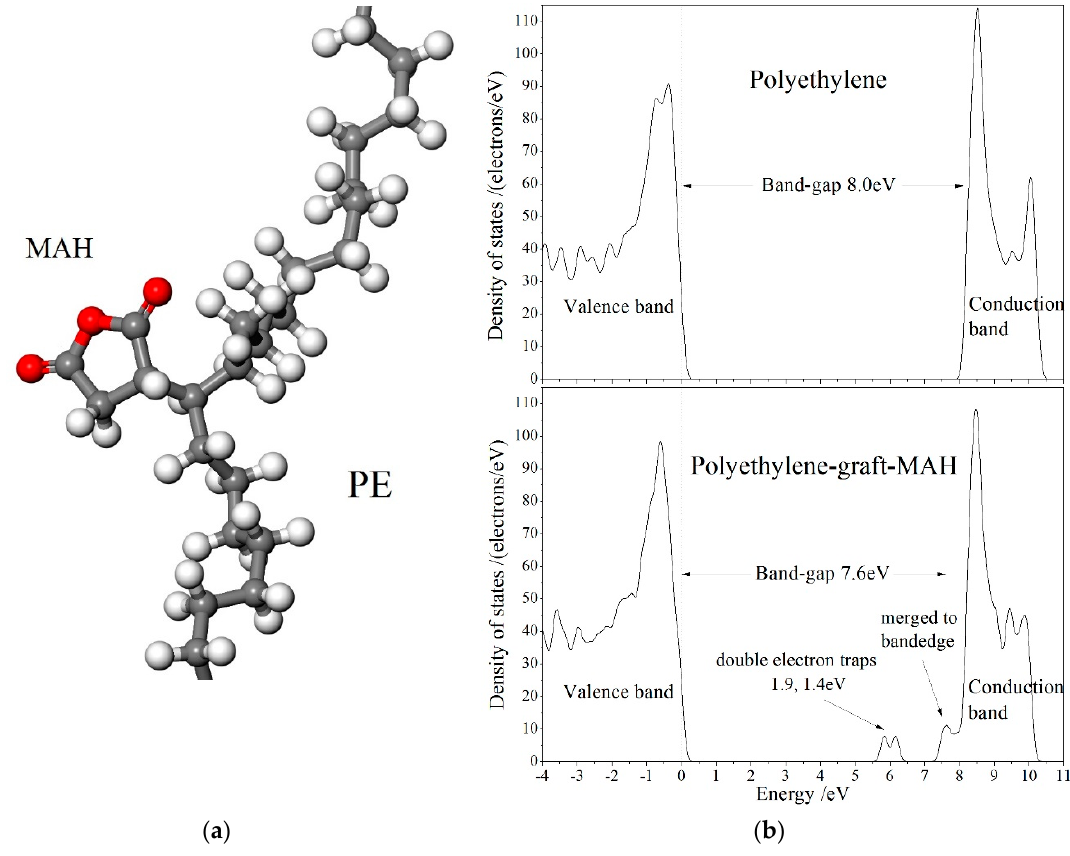
Figure 4. ( a ) Schematics of grafting MAH to polyethylene molecule with gray, white and red spherules identifying carbon, hydrogen and oxygen atoms respectively; ( b ) density of states (DOS) of PE and PE-g-MAH from first-principles calculations, in which the highest occupied molecular orbital (HOMO) level is set as the energetic zero, as indicated by the vertical dashed line.